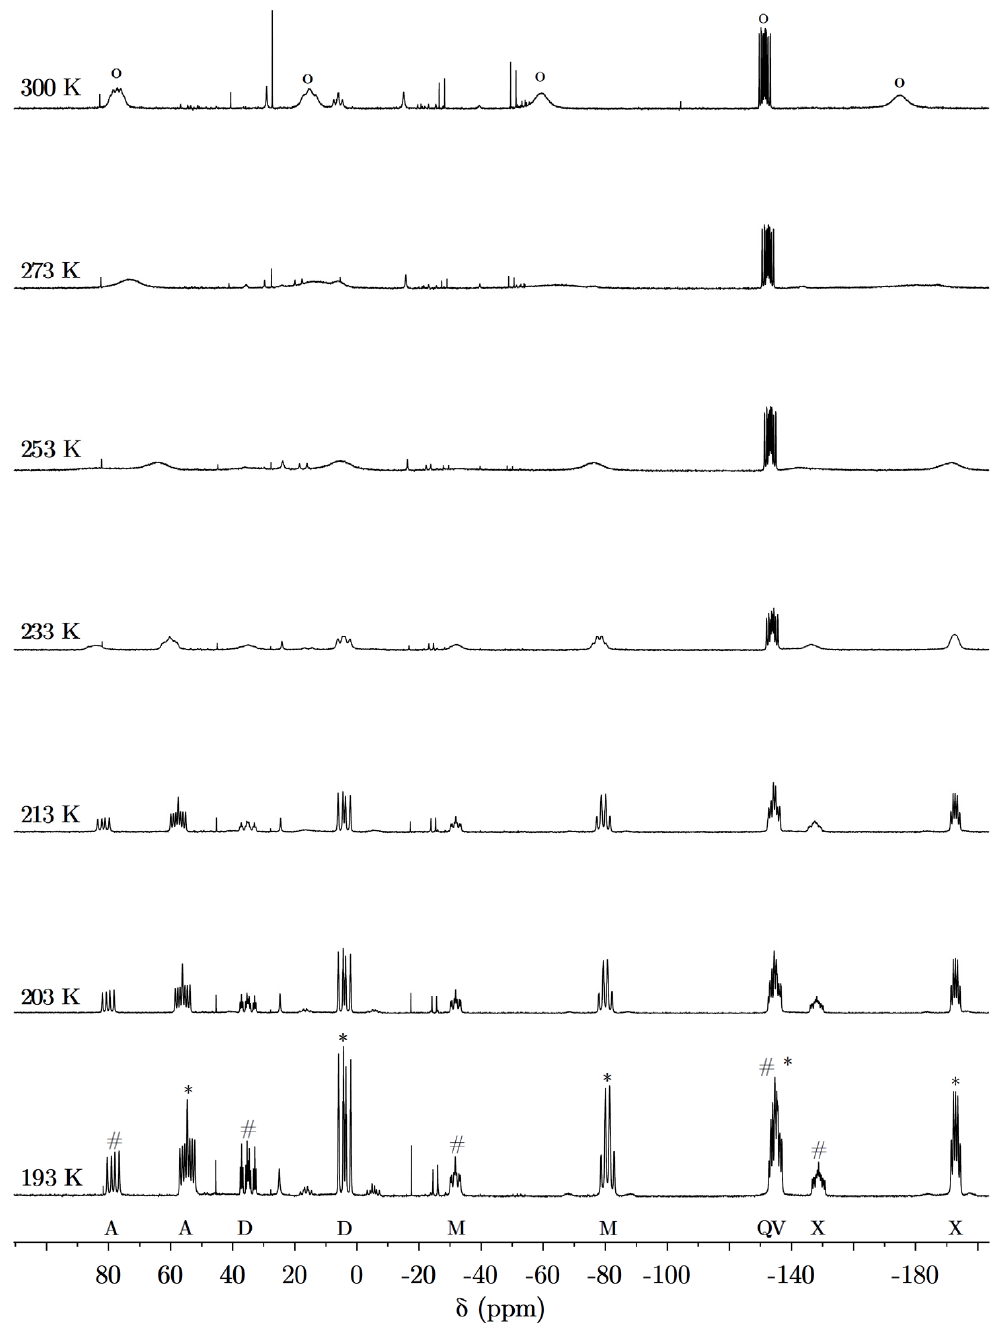
Figure 3. 31 P{ 1 H} VT NMR spectra of the reaction solution of 1 with [Ph 2 P][OTf] in CD 2 Cl 2 ( ∗ = 2a , # = 3 , o = broad signals at r.t.).